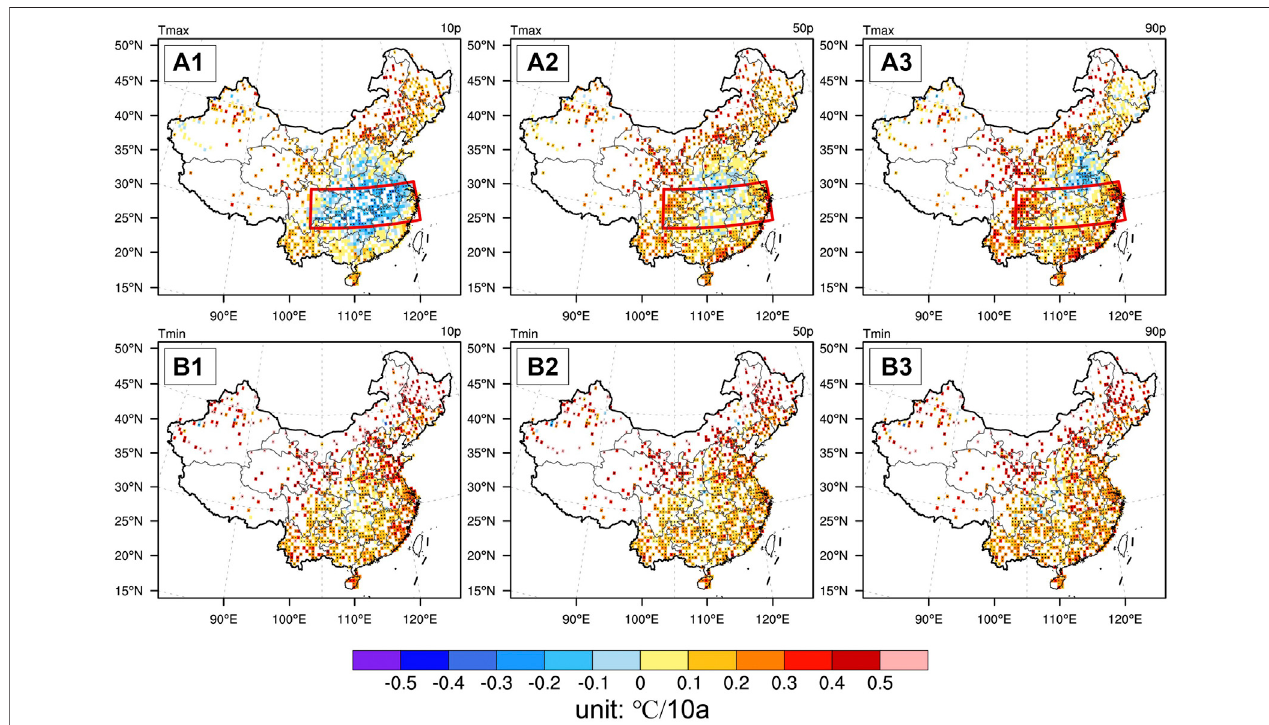
FIGURE1| Thequantiletrendsof1961 – 2017summertimeTmax[row (A) ]andTmin[row (B) ]at10th(column1),50th(column2),and90th(column3)percentiles, unit: ° C/10a. Stippling regions denote trends that are statistically signi fi cant at 95% con fi dence level. The red boxes in the panel (A) represent the Yangtze River Basin (YRB; 27 – 33 ° N, 103 – 122 °